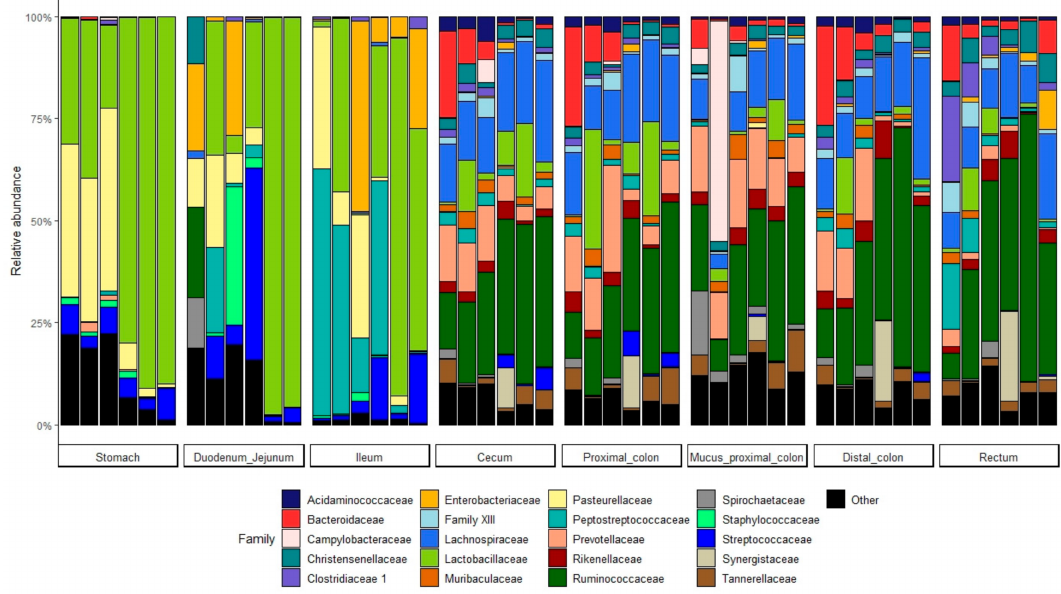
Figure 3. Relative abundance of the main bacterial families in the stomach and intestine segments of 6 weaning